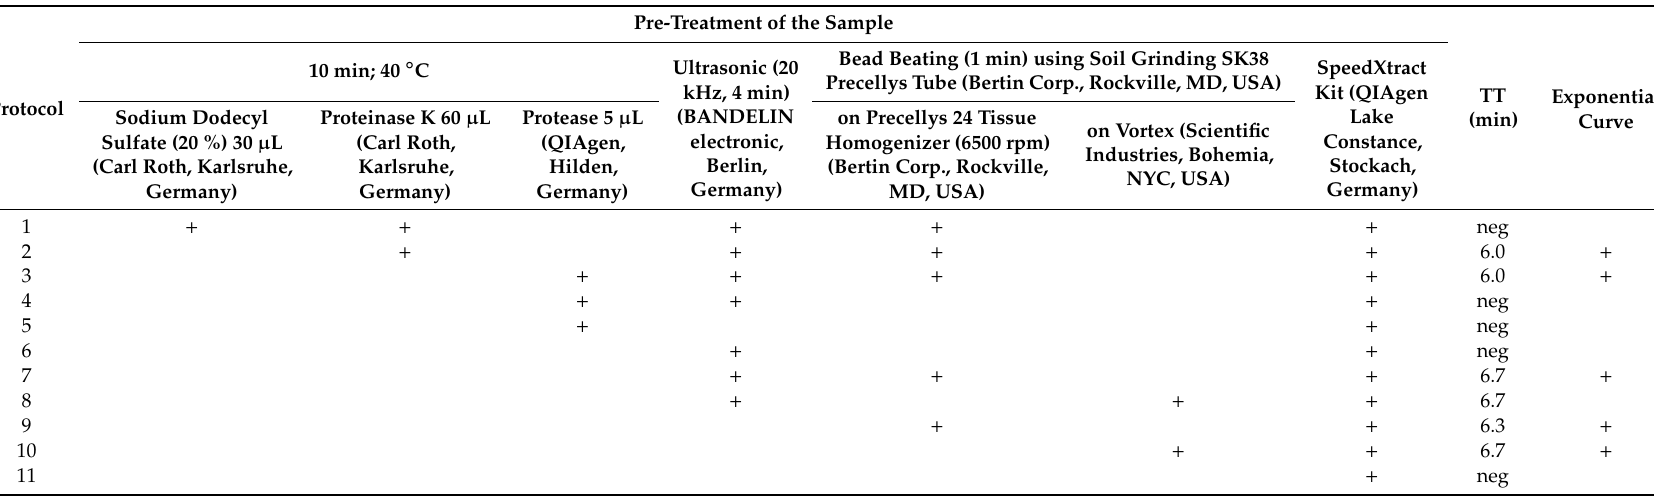
Table 1. Di ff erent DNA extraction protocols. Eleven variations of the pre-treatment of the sample were applied to select the most field applicable method. Faecal samples were diluted using the Lysis Bu ff er before pre-treatment step. Magnetic beads were added after the pre-treatment step. TT is Threshold Time of recombinase polymerase amplification (RPA); neg is negative; + is employed in the respective